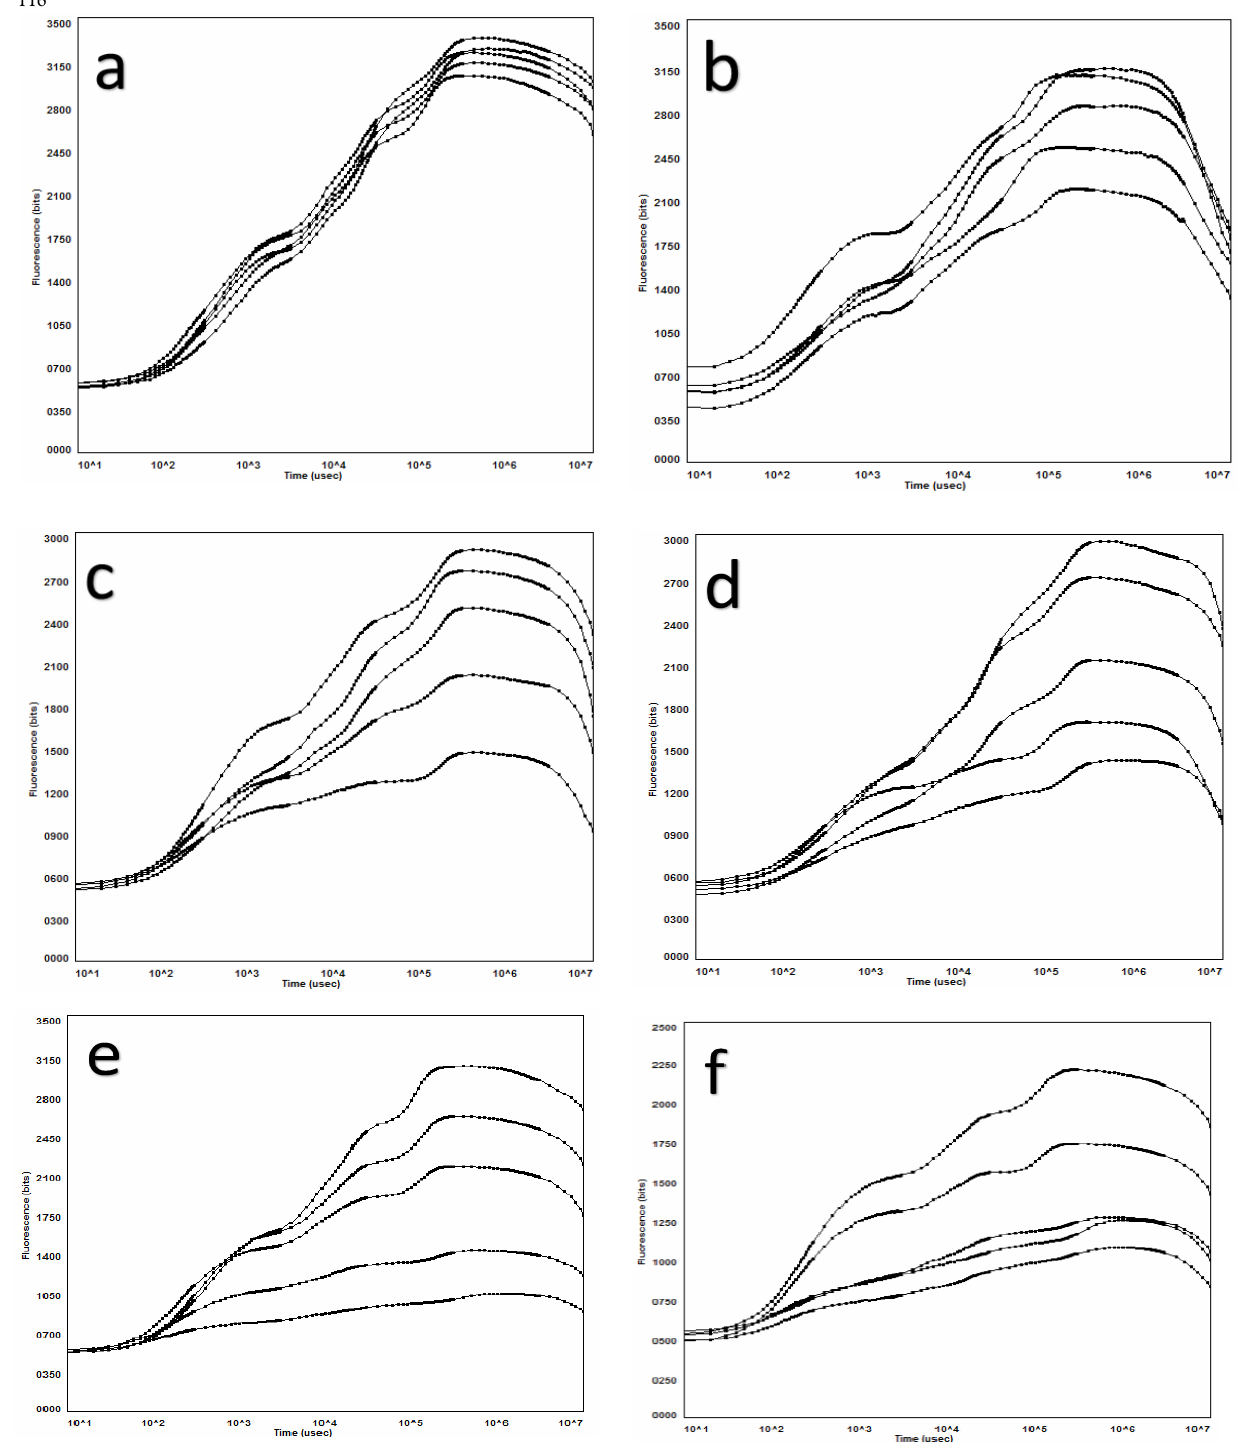
Fig. 3. Effect of sethoxydim plus turnip oil on the shape of the katusky curve in wild oat at 1, 2, 3, 5 and 7 days after treatment: a; 0, b; 45, c; 94, d; 187, e; 281 and f; 375 gr a.i. were between 0.835 and 0.846 at all times of measurement. emulsifiable turnip oil as adjuvant was higher compared By increasing the dose of the sethoxydim Fv/Fm-values sethoxydim alone. Fv/Fm decreased with past time as 7 were decreased whereas after 7 DAS Fv/Fm of 0.846 DAS at least this parameter was observed (Fig. 4). (control) get to 0.479 and 0.547 at the recommended dose (375 g. ai. ha -1 ) with and without emulsifiable turnip oil respectively. Rate of decrease Fv/Fm-values for applied